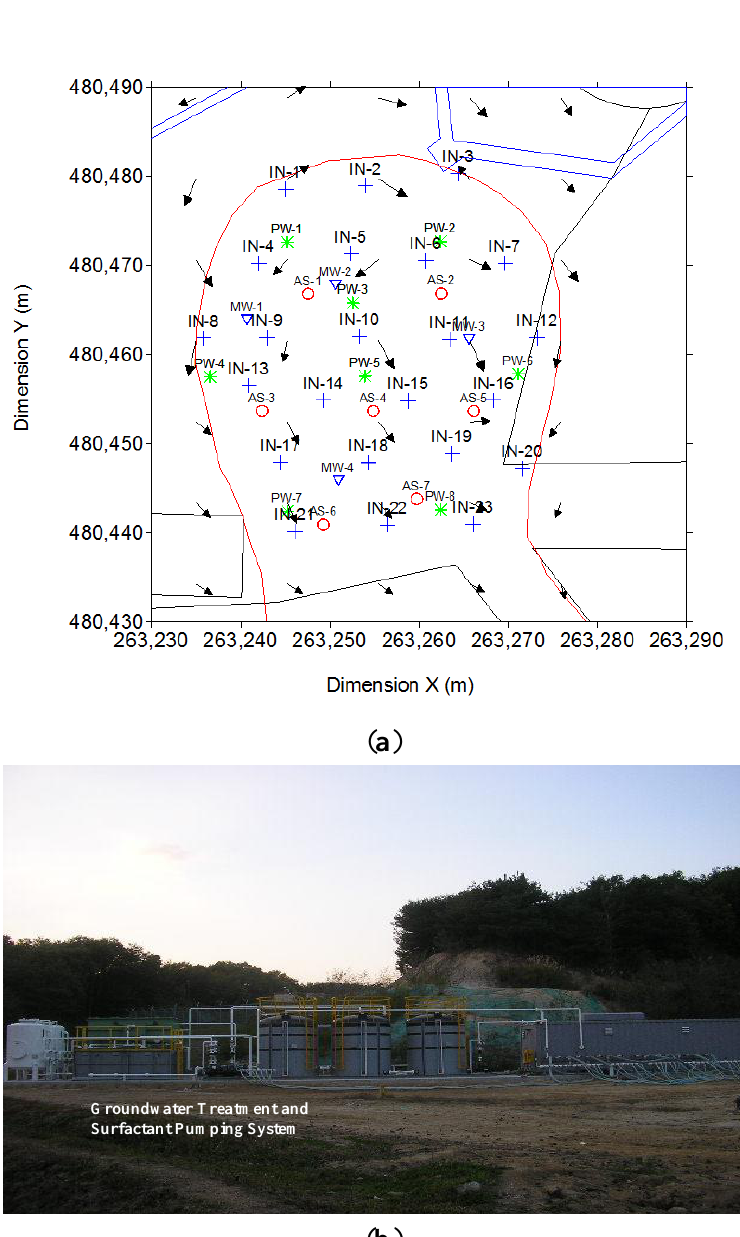
Figure 3. The target area in this study: ( a ) Location map of the wells installed in the study, including the monitoring well (MW), injection well (IW), pumping well (PW) and air sparging well (AS). ( b ) A photo of the study area at the